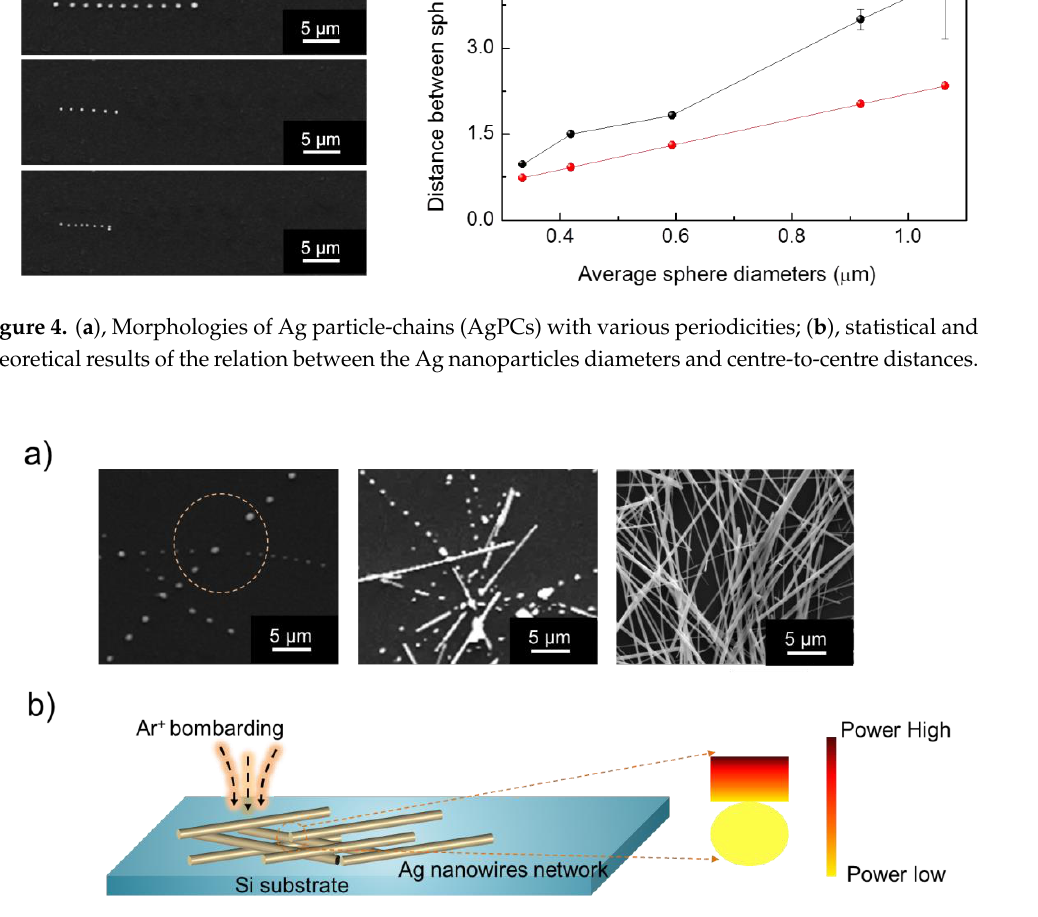
Figure 5. ( a ), Schematic illustration of the plasma surface modification on Ag nanowires networks, ( b ), morphologies of Ag nanowires with different aggregations after 60 W plasma treatment for 5 min.